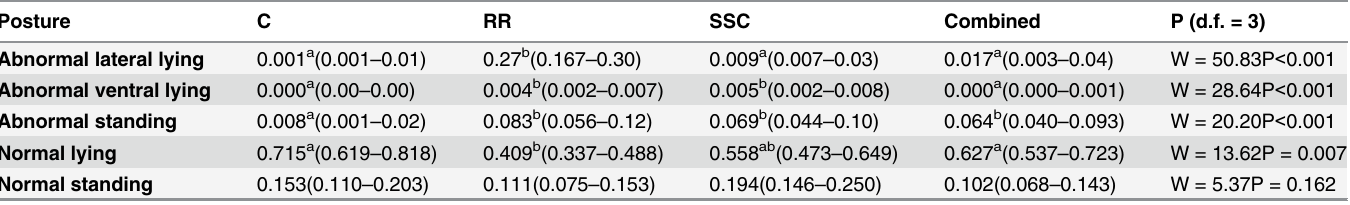
Table 3. The effect of different methods of castration on the proportion of time spent by lambs in abnormal and normal standing and lying pos- tures in the 30 minutes following treatment. Posture C